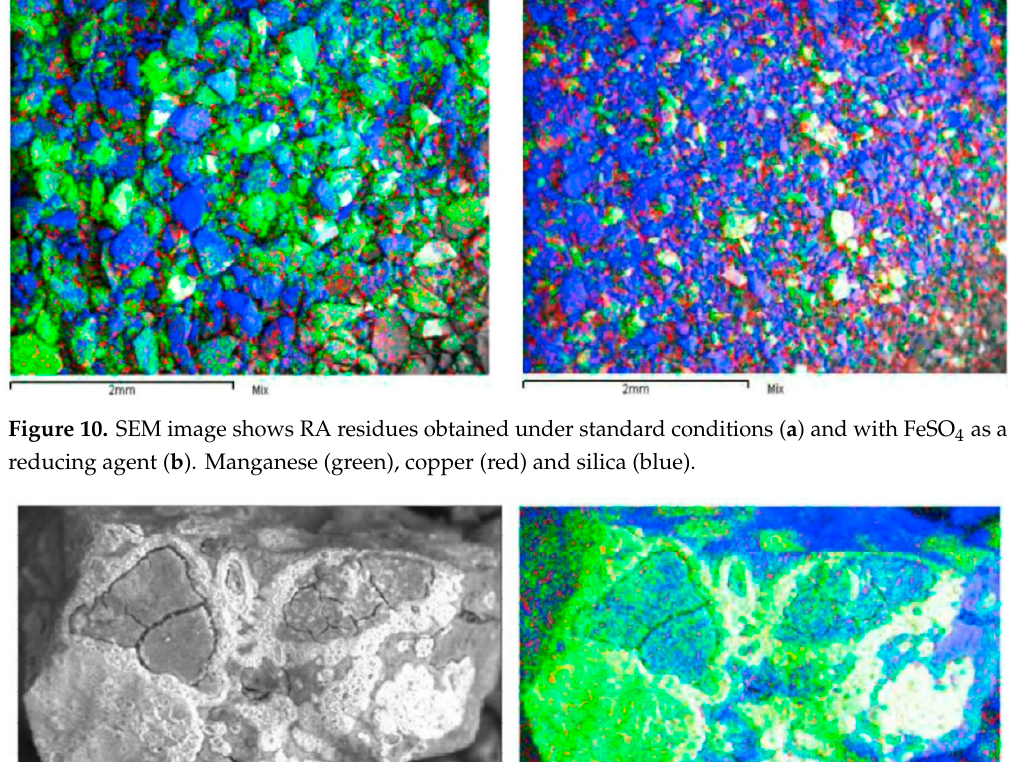
Figure 10. SEM image shows RA residues obtained under standard conditions ( a ) and with FeSO 4 as a reducing agent ( b ). Manganese (green), copper (red) and silica (blue).